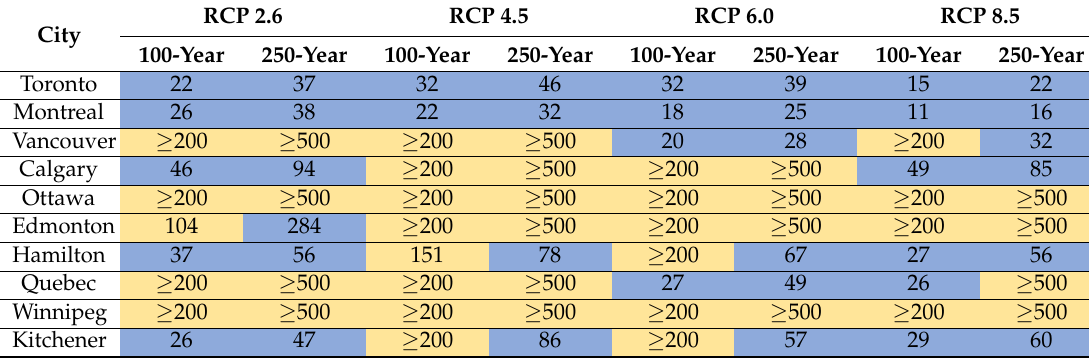
Table 2. Projected future return periods of historical 100-year and 250-year return period flood events for 10 most populated Canadian cities obtained from robust GCM median approach. Return periods greater than 200 (500) are only provided categorically in case of 100-year (250-year) return period events. Cases projected with future increases in flooding frequencies are shown in blue whereas cases projected with future decreases in flooding frequencies are shown in orange.